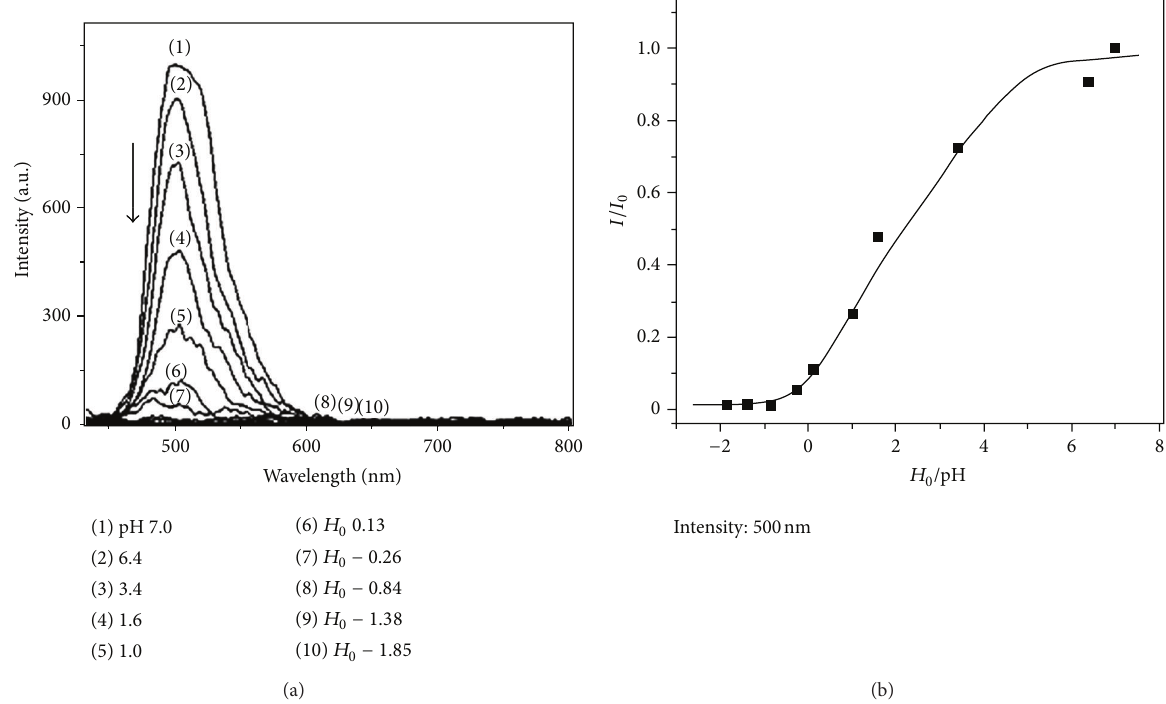
Figure 10: (a) Fluorescence spectra of C334 at various pH in 𝛽 -CD. (b) 𝐼/𝐼 0 versus 𝐻 0 /pH plot of C334 in 𝛽 -CD.